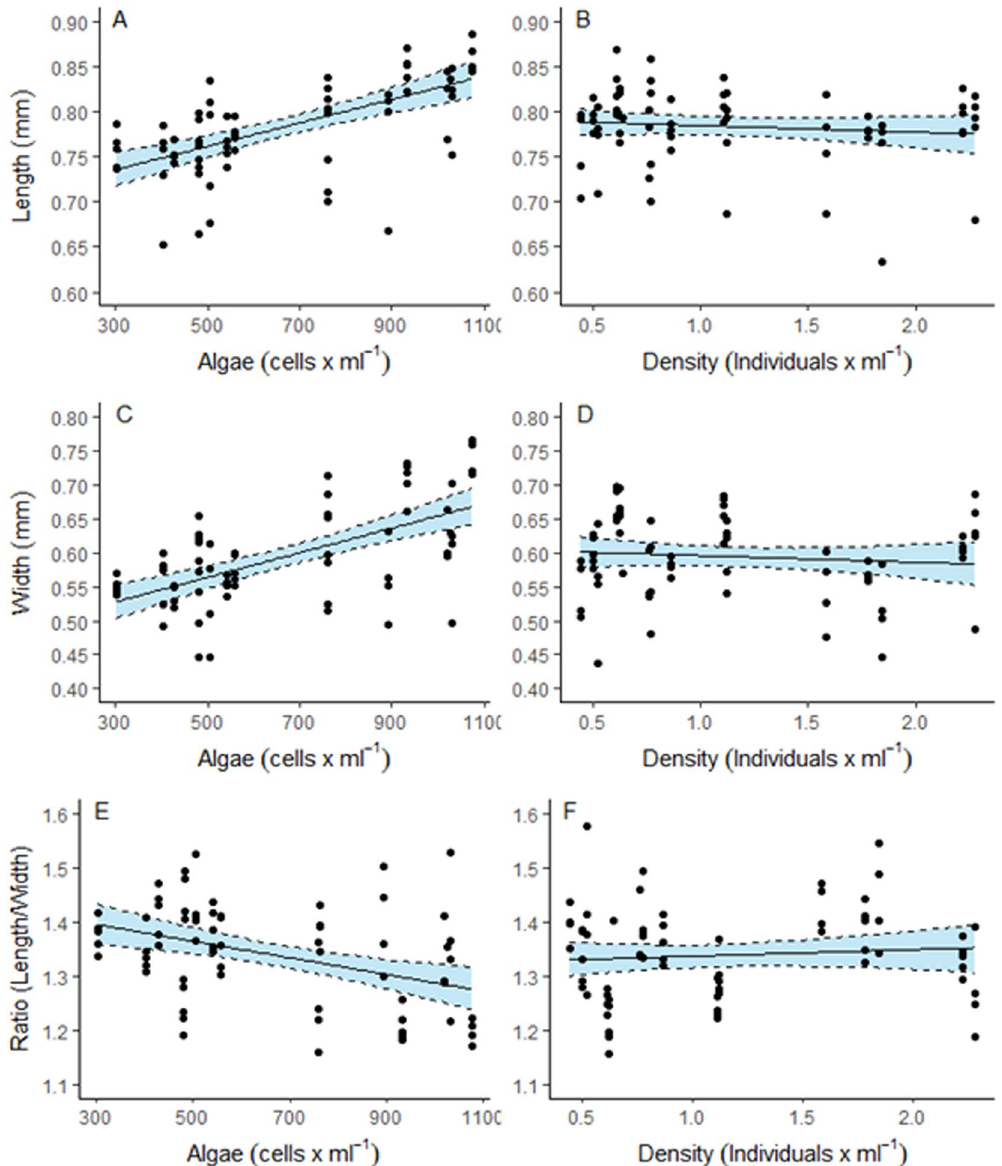
Figure 3. Modelled larvae length ( A , B ), width ( C , D ) and ratio ( E , F ) against algae concentration and larvae density of Acanthaster cf . solaris larvae 10 days post fertilisation. Confidence intervals derived from bootstrap (N = 1000) analyses, dots represent partial residuals at the tank level derived from the